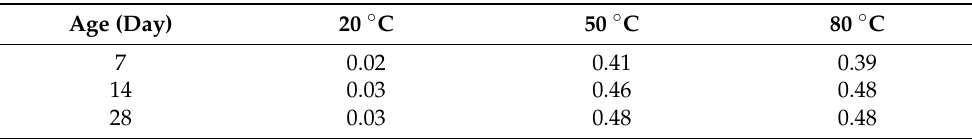
Figure 12. DSC and DTG curves of MgO-SF pastes using MgO calcined at 1450 °C for 2 h. Table 4. Mg(OH) 2 content calculated from Figure 12 w /%.